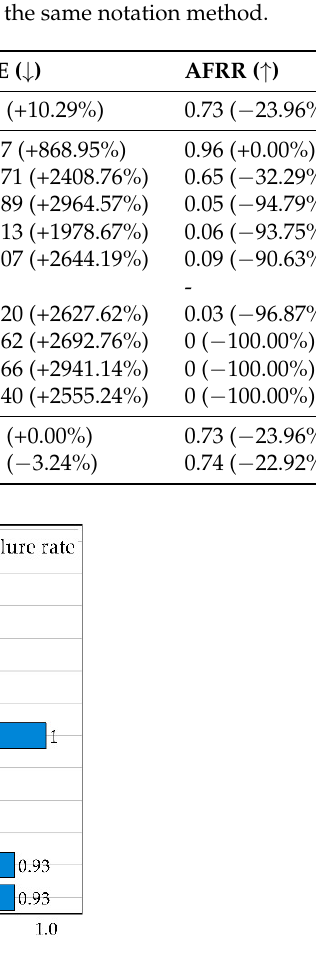
Figure 8. Comparison of failure rates of different comparison methods.